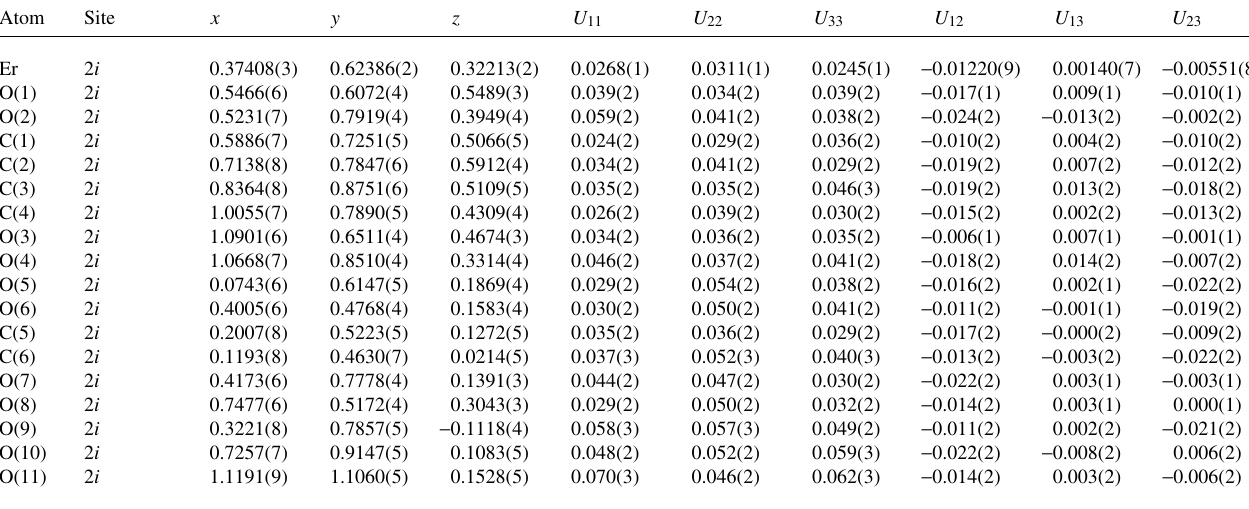
Table 3. Atomic coordinates and displacement parameters (in Å 2 ) .